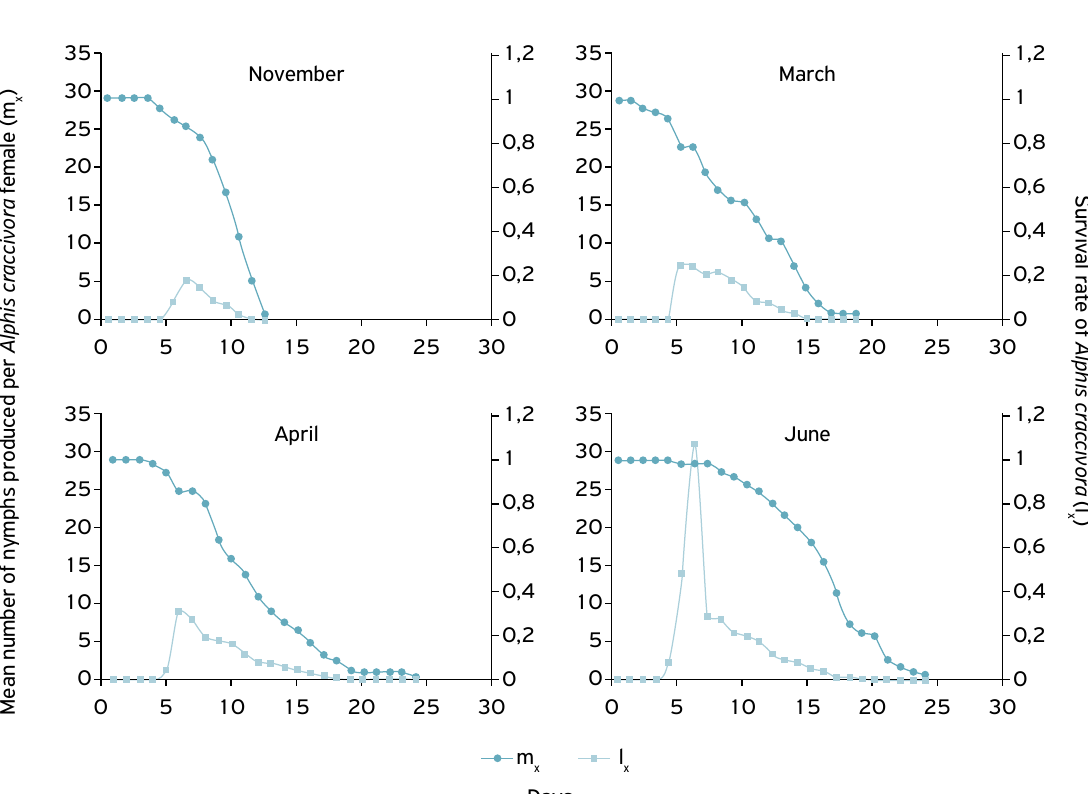
) and survival rate (1 ) of Aphis craccivora in cowpea under “natural” conditions. x x